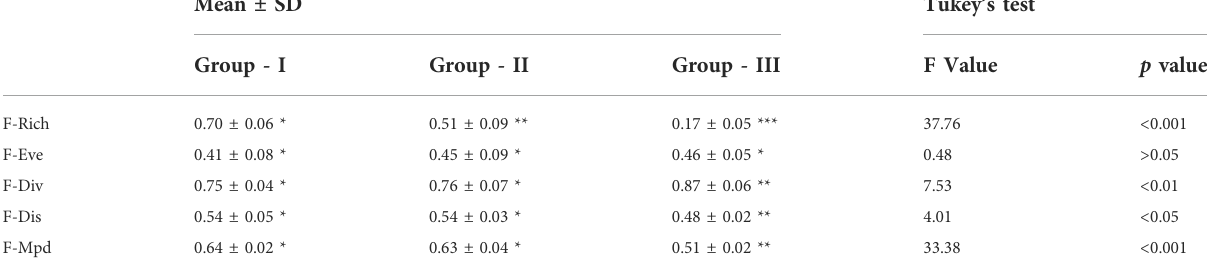
TABLE 3 Mean of functional diversity indices for the water quality groups based on their seasonal calculation at each study site.